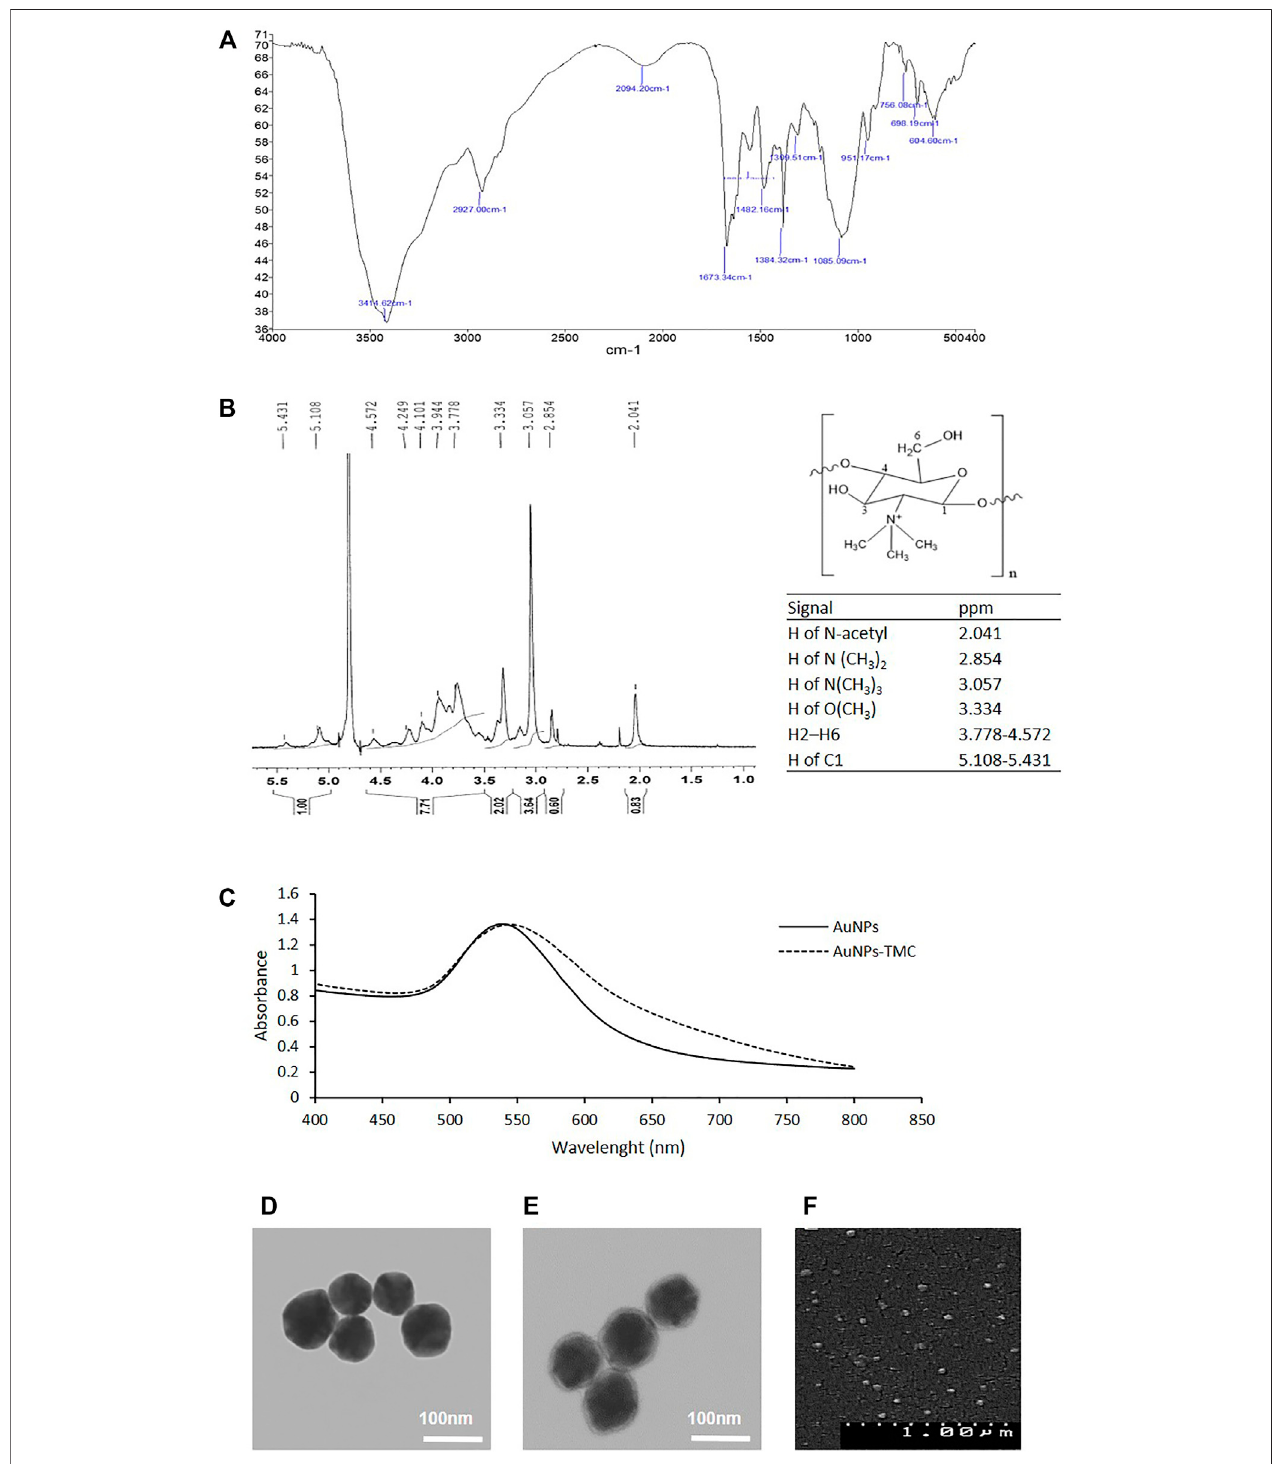
FIGURE 1 | Synthesis and characterization of the AuNPs-TMC: (A) FTIR spectrum of TMC. (B) NMR Spectrum of TMC. (C) UV – Vis spectrum of AuNPs and AuNPs-TMC. (D) TEM image of AuNPs. (E) TEM image of AuNPs-TMC. (F) SEM image of AuNPs-TMC.